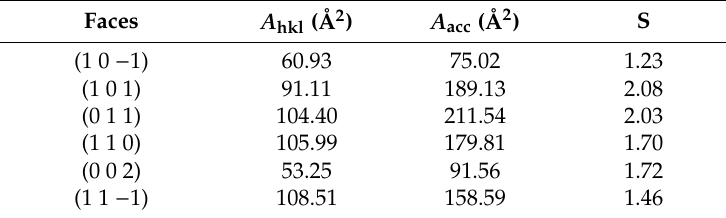
Figure 7. Solvent-accessible areas (the blue grid) of the six important faces of the catechol crystal represented by the Connolly surface. Table 4. The roughness values (S) of the dominant crystal faces of the catechol crystal.